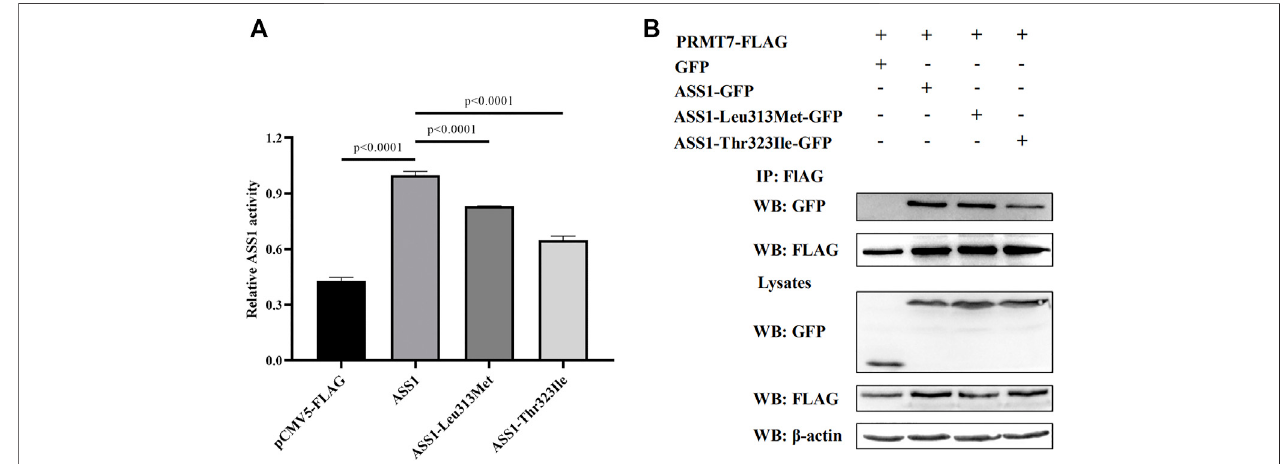
FIGURE 2 | Functional analysis of ASS1 mutations. (A) Effect of p. Leu313Met and p. Thr323Ile mutations on ASS1 activity. The enzymatic activity of ASS1 immunoprecipitated from HEK293 cells expressing pCMV5-FLAG empty vector, ASS1-FLAG, ASS1-Leu313Met-FLAG, or ASS1-Thr323Ile-FALG was determined. DataarenormalizedtoASS1wild-typeprotein(lane2).Threeindependentexperimentswereperformed.Statisticalsigni fi cancewasdeterminedbyone-wayANOVA. (B) Effect of p. Leu313Met and p. Thr323Ile mutations on the ASS1 – PRMT7 interaction. HEK293 cells co-expressing PRMT7-FLAG and GFP, or PRMT7-FLAG with ASS1-GFP,ASS1-Leu313Met-GFP,orASS1-Thr323Ile-GFPwereharvested.PRMT7-FLAGwasimmunoprecipitatedusinganti-FLAGM2Beads.Immunoprecipitates wereanalyzed bywesternblottingusinganti-GFPandanti-FLAGM2antibodies.Totalcelllysates wereanalyzedbywesternblottingusinganti-GFP,anti-FLAGM2,and anti- β -actin